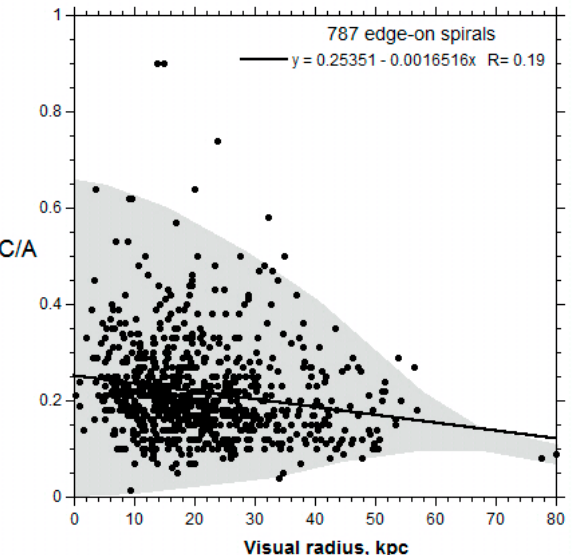
Figure 8. Dependence of the axial ratio on radius for galaxies categorized as edge-on in the NED database [42]. The linear least squares fit excludes one spiral with A = 235 kpc and C / A = 0.061. The grey area shows that the spread in C / A ratios decreases with galaxy size. Our analysis shows that galactic evolution progresses right to left on this diagram.